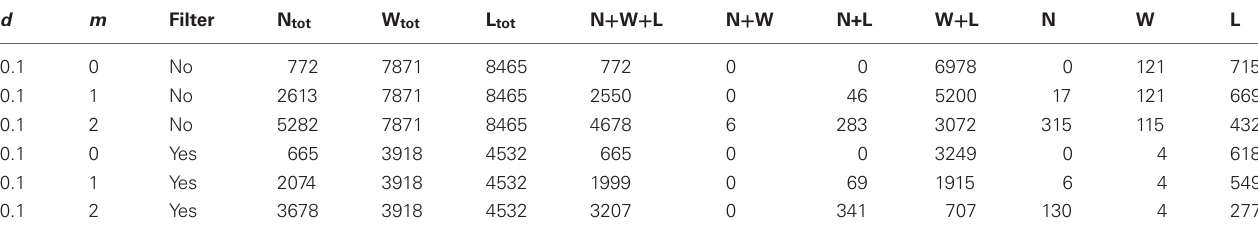
Table 2 | Number of differentially methylated